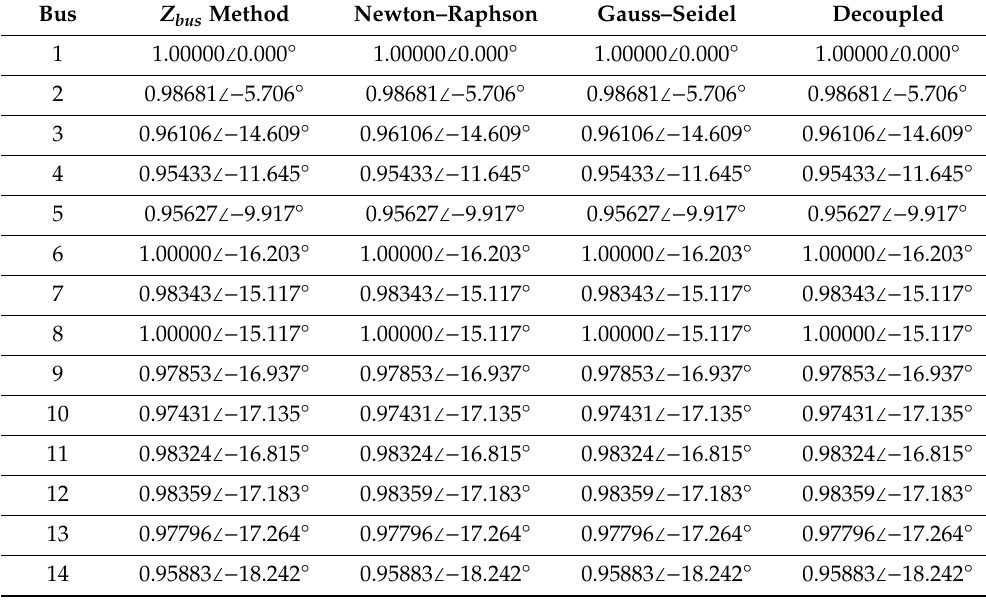
Table A1. Voltage profile of the IEEE 14-bus system (in